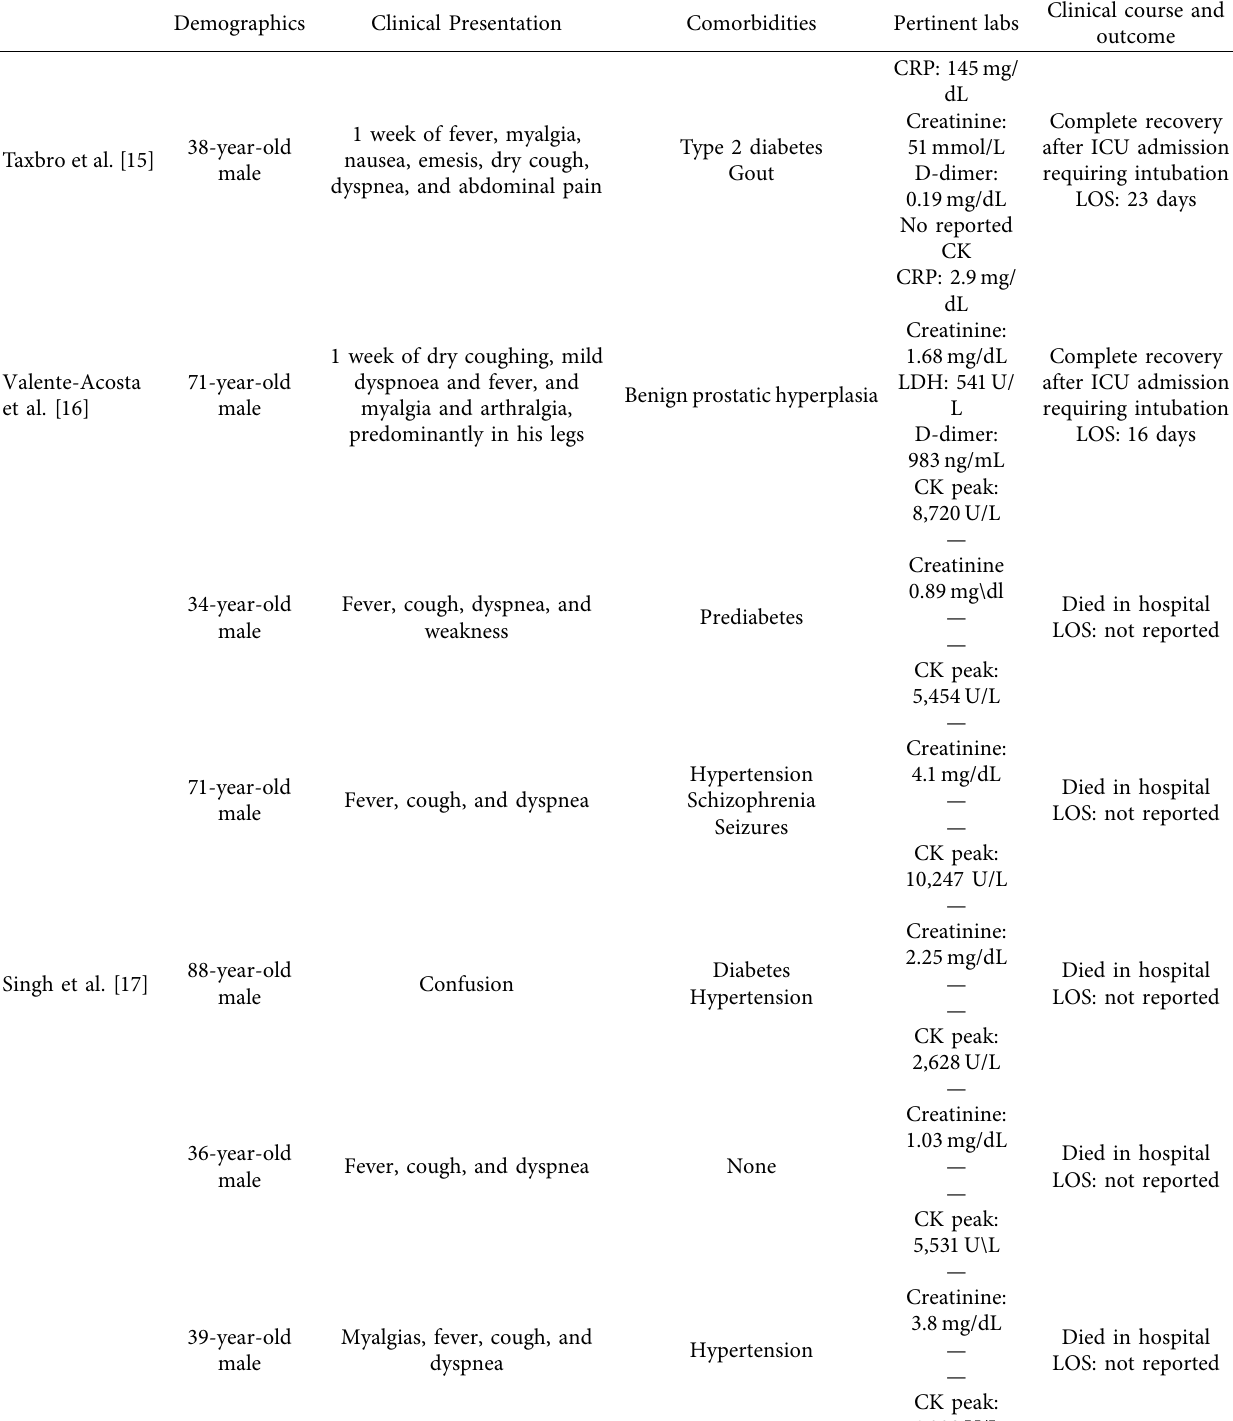
Table 1: Summary of the reported